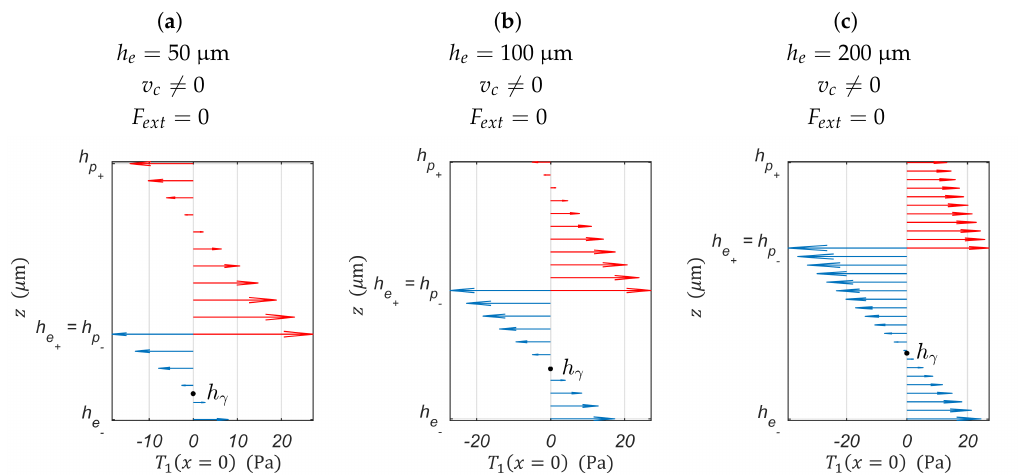
Figure 5. Piezoelectric actuation neutral axis evolution due to elastic layer thickness change. The piezoelectric layer is made of PSI-5H4E, and the elastic layer is Ag . The piezoelectric layer thickness is fixed at h p = 100 µ